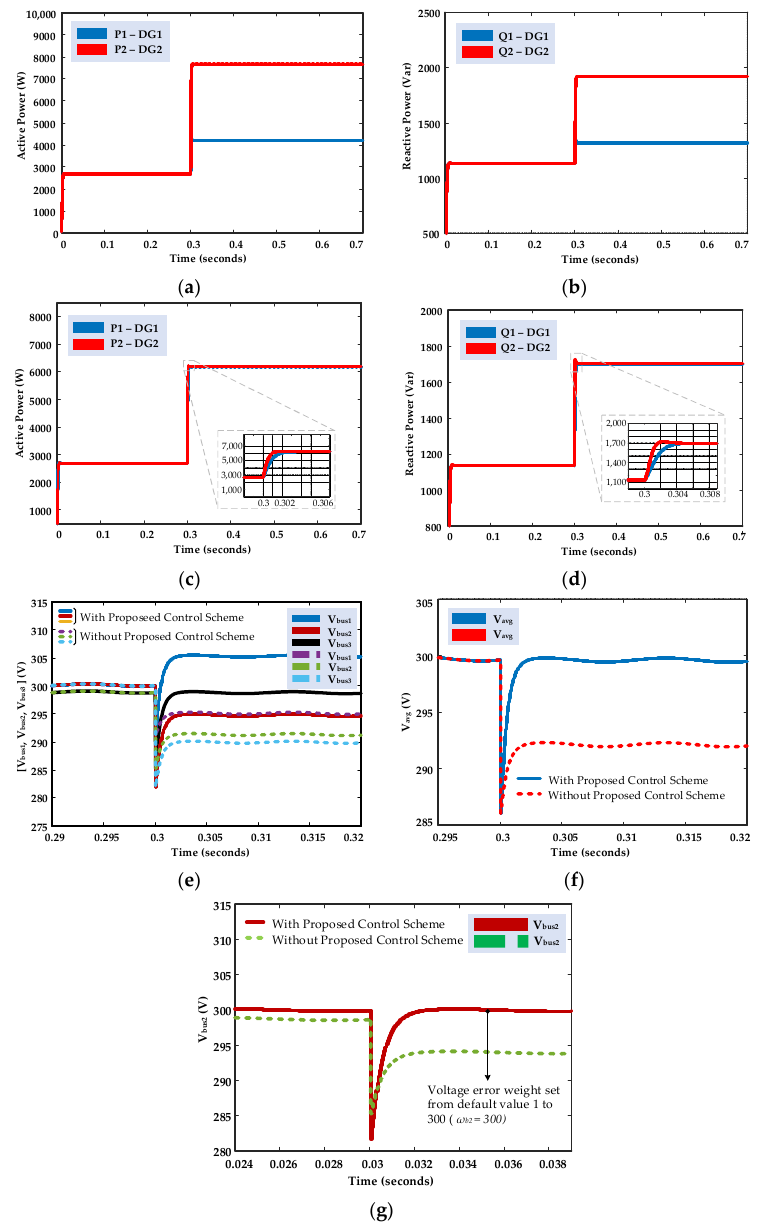
Figure 9. Simulation results. ( a ) Active power response without proposed control scheme. ( b ) Reactive power response without proposed control scheme. ( c ) Proportional active power sharing proposed control strategy. ( d ) Proportional reactive power sharing with proposed control strategy. ( e )